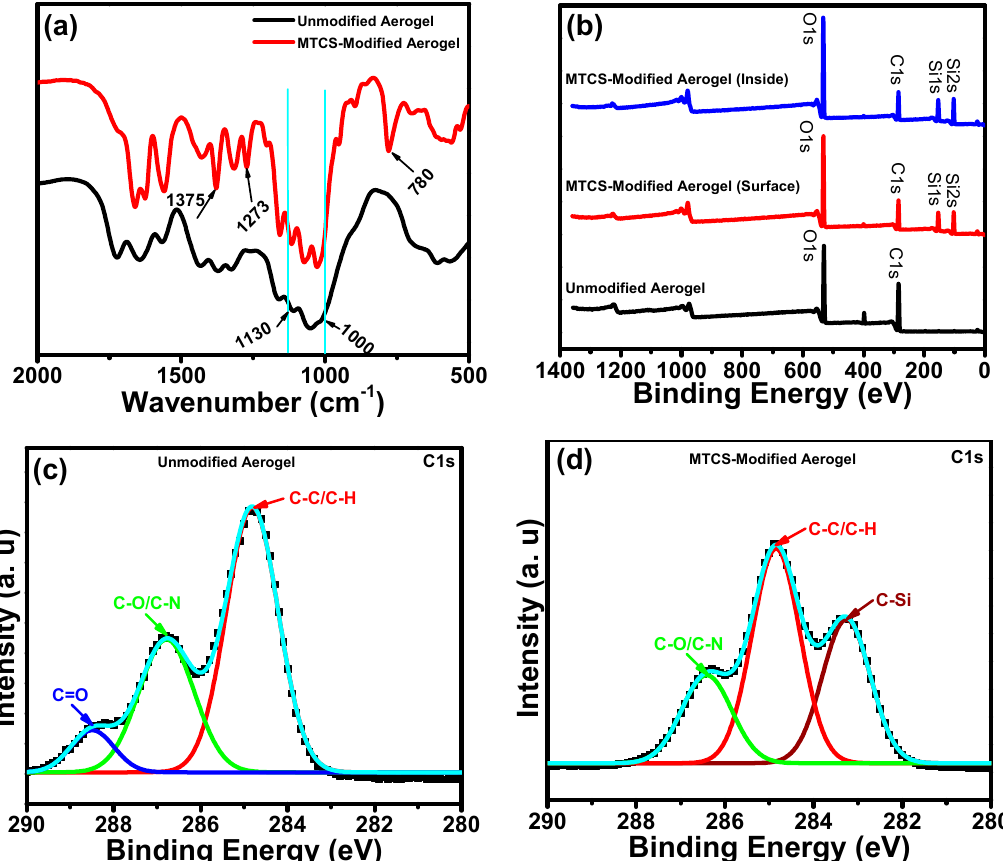
Figure 6. ( a ) FTIR spectra, ( b ) XPS survey spectra, ( c ) the high-resolution C1s spectrum of ChiNC/TCNF/CGG aerogels before modification, and ( d ) high-resolution C1s spectrum of ChiNC/TCNF/CGG aerogels after modification.